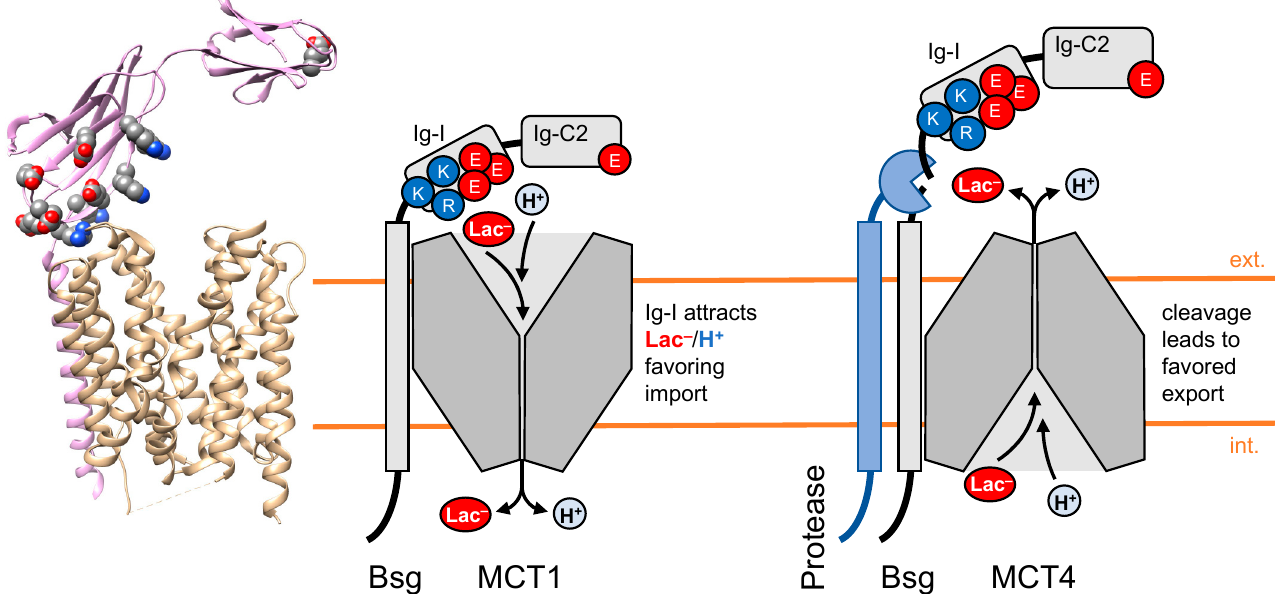
Figure 2. Contribution of the extracellular basigin (Bsg) Ig-domain to secondary-active MCT lactate/H + transport (structure PDB# 6lz0). Two oppositely charged domains of the IgI domain act as a bivalent antenna for monocarboxylate substrate anions and co-substrate protons, increasing inward transport velocity and capacity (left schematic). Cleavage of the extracellular basigin domain by a protease promotes lactate/H + export via MCT4 (right). Key amino acid residues are shown as spheres in the cartoon (Bsg: pink; MCT1: sand; carbon: gray; nitrogen: blue; oxygen: red).